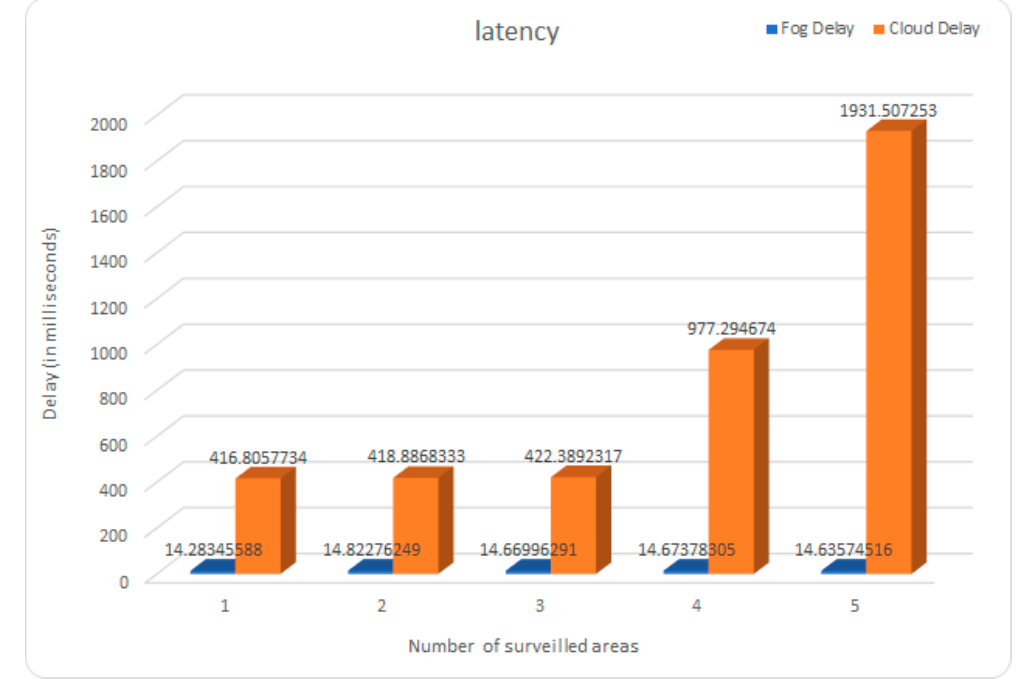
Figure 2. Latency average in fog and cloud platforms.